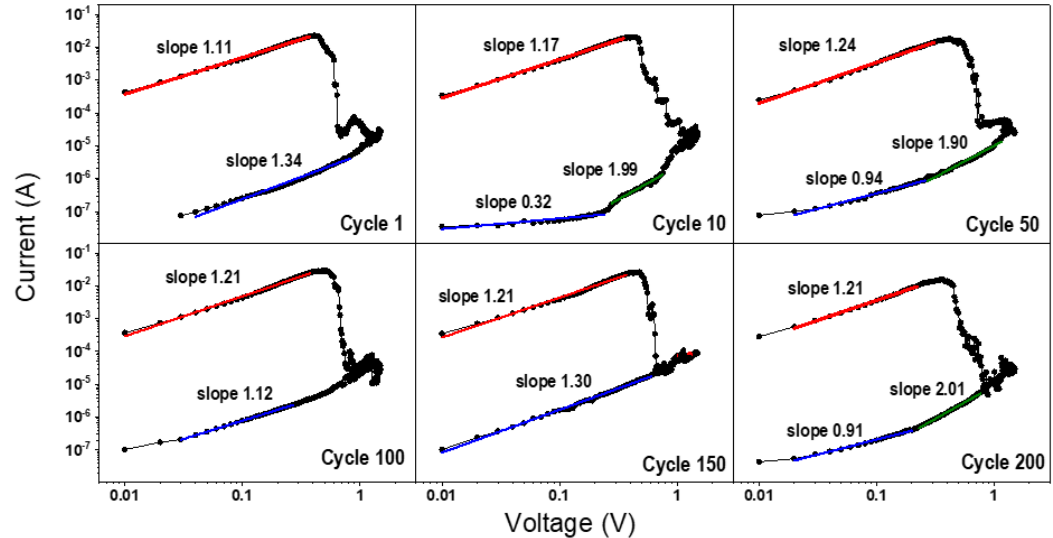
Figure 7. The current–voltage curves replotted on a log–log scale in the positive bias voltage range for cycles 1, 10, 50, 100, 150 and 200.